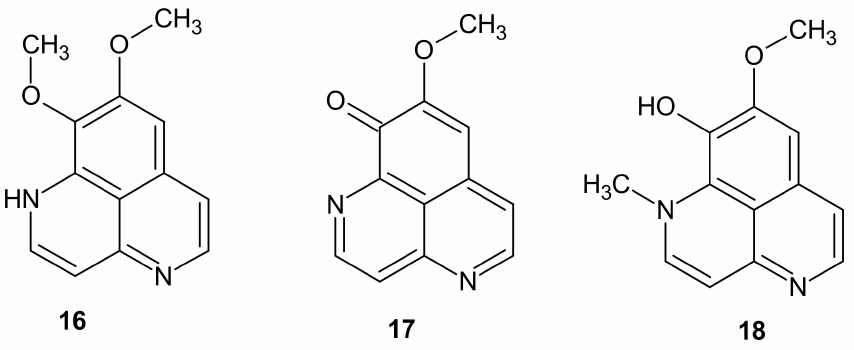
Figure 5. Aaptamine derivatives 16 – 18